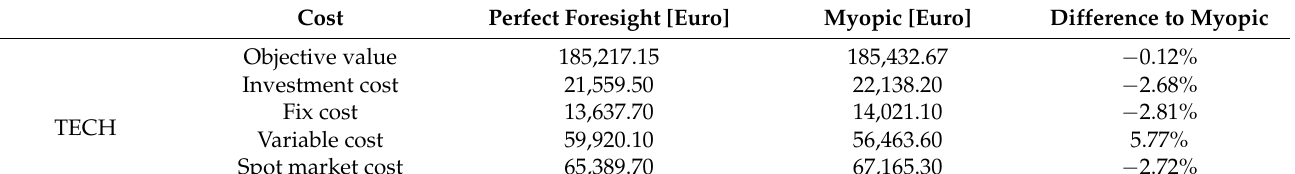
Table 6. Comparison of objective value and costs of the TECH scenario.